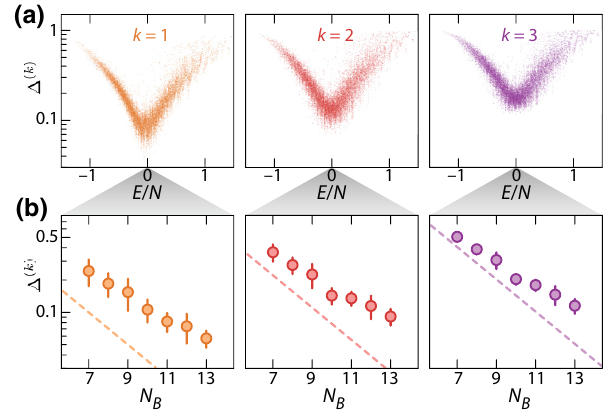
FIG. 4. Emergent quantum state designs from energy eigen- states. (a) The trace distances between the k th moments of the Haar ensemble and a projected ensemble for an N A = 3 subsys- tem generated from the energy eigenstates of a Hamiltonian. The results are presented as a function of the energy density E / N for a total system size of N = 14. (b) The trace distances for the projected ensembles obtained from eigenstates near zero energy corresponding to infinite temperature. The distances exhibit an exponential decay as a function of the system size. The points are evaluated for 100 eigenstates near zero energy and the error bars denote their standard deviation. For comparison, the dashed between the Haar ensem- lines represent the trace distances (cid:10) ( k ) em ble and an empirical ensemble of 2 N B states sampled from the Haar